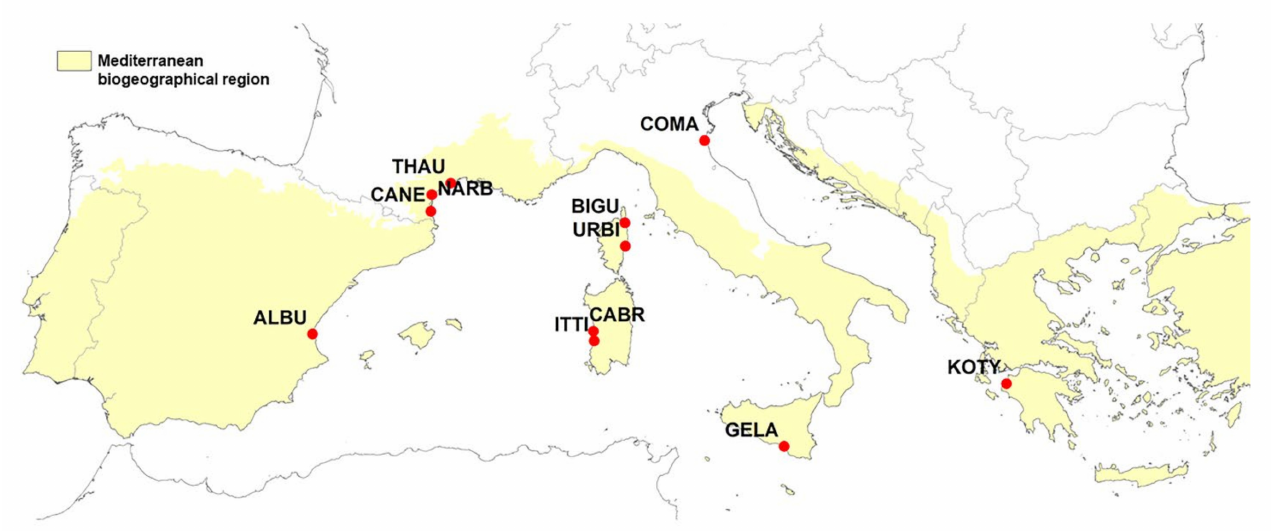
Figure 1. Map of the location of the waterbodies where land uses in the catchments were determined for pollution pressure estimation; all located within the European Mediterranean biogeographical region. The sites tested for hydro-morphological pressures are listed in Table